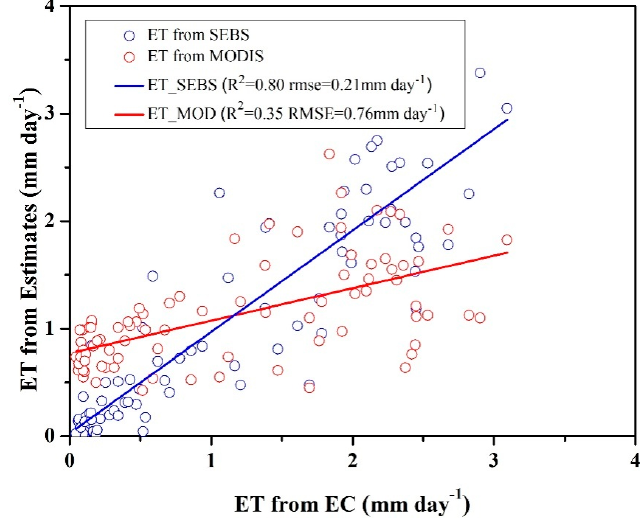
Figure 4. A plot of the eight-day average SEBS simulated ET versus EC measurements.